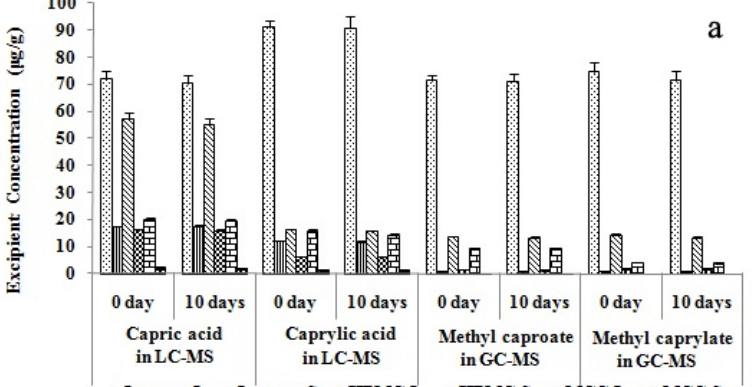
Figure 4. Thermal stability of Labrasol ® and Transcutol ® assessed by LC-MS and GC-MS. Labrasol ® ( a ) and Transcutol ® ( b ) concentrations measured by LC-MS and GC-MS are shown (n = 4, p > 0.05). The 0-day concentrations were measured before